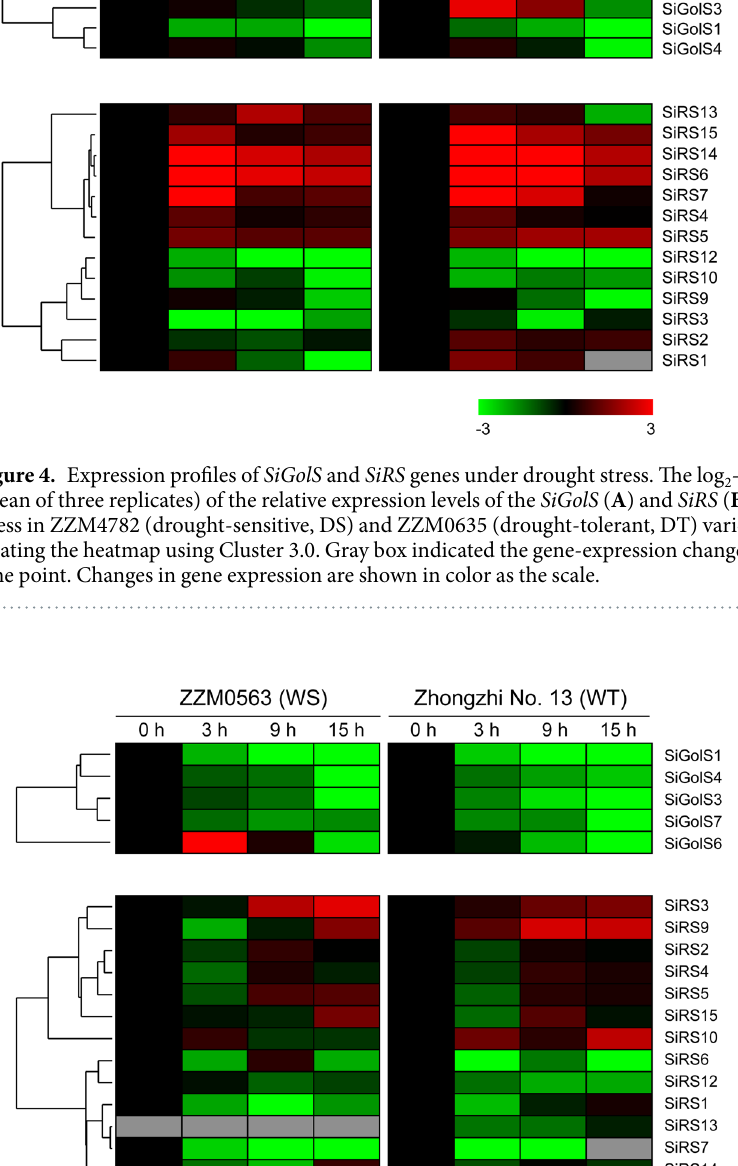
chosen for further investigation of their expression patterns in shoot under osmotic, salinity, and cold treatments by qPCR. Under osmotic stress, SiGolS2 and SiGolS7 were significantly up-regulated (fold change > 2) during the whole treated time points, while the other 3 SiGolSs exhibited no significant change (Fig. 6A and Supplementary Fig. S8). Under salt treatment, 3 SiGolSs ( SiGolS2, 4 , and 7 ) were significantly induced (fold change > 2) during